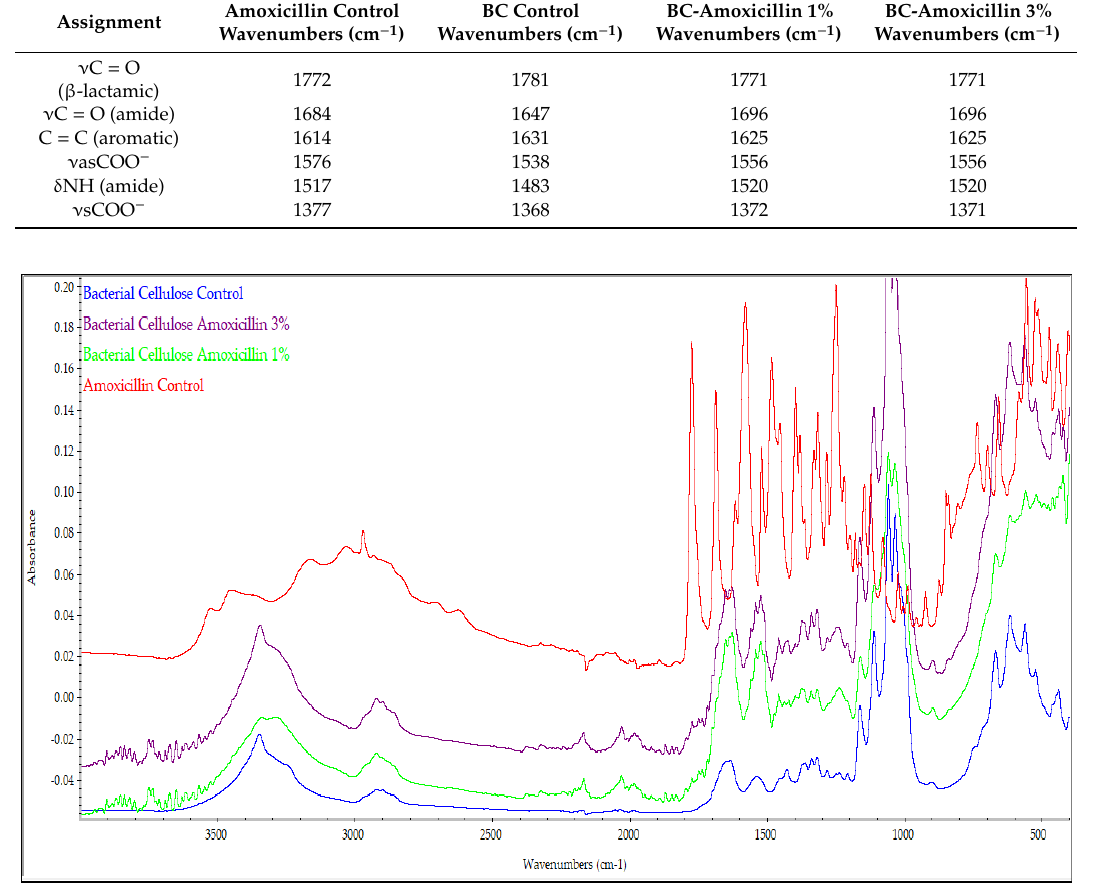
Table 2. Assignment of relevant IR absorption bands of amoxicillin.